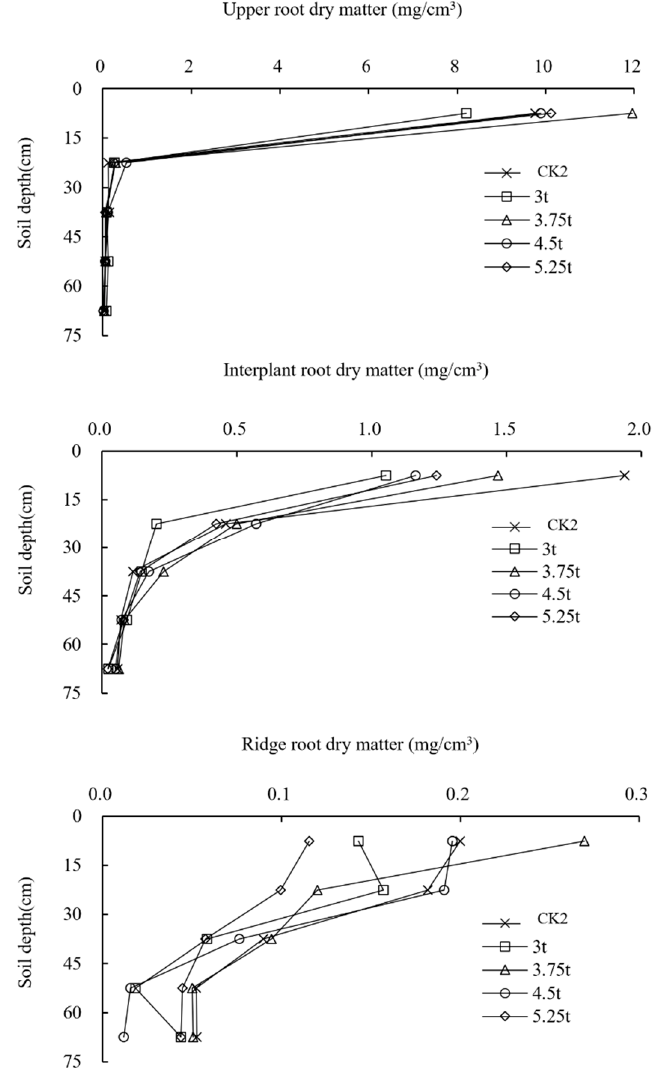
Figure 3. Effects of the carbon-based fertilizer on the maize root dry matter distribution (taking Jingke 968 as an example).